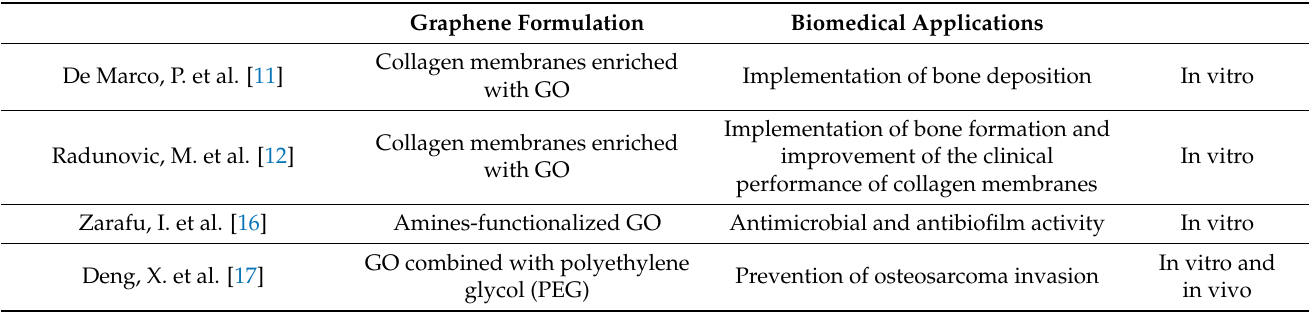
Table 1. Biomedical applications of GO. The table summarizes in vitro and in vivo studies related to GO and